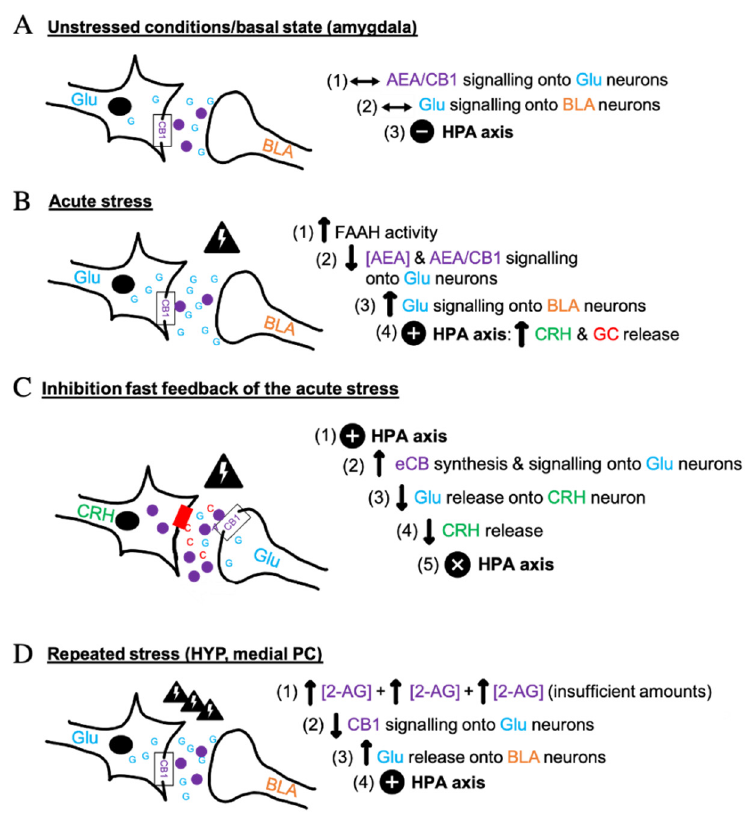
Figure 1. Interaction between endocannabinoids, glutamate, and the HPA axis under stressful conditions. This figure summarizes the theory presented by Hill et al. (2010) about the intervention of eCBs, the glutamatergic (Glu) system, glucocorticoids (GC) and the corticotropin-releasing hormone (CRH) in response to different stressful stimuli, the stress response being dependent on glutamatergic neurons and CB1 signaling in murine models. The synapses illustrated occur in the amygdala, hypothalamus (HYP), hippocampus or prefrontal cortex (PC). Symbols show the nature of the effect on the HPA axis, either neutral ( − ), excitatory ( + ) or inhibitory ( x ). ( A ) The non-stressed condition enables to maintain normal levels of AEA and to stabilize Glu activity onto the basolateral amygdala (BLA) neurons, which does not affect the HPA axis. Under acute stressful situations ( B ), the HPA is activated to ensure the survival of the organism. In response to stress, fatty acid amide hydrolase (FAAH) activation promotes the hydrolysis of AEA in all brain regions considered, whereas there are unchanged or lower 2-AG levels in the amygdala and in the HYP, respectively. The impaired AEA/CB1 signaling onto Glu synapses in turn induces a higher Glu input onto BLA neurons. A negative fast feedback occurs when there is a hypersecretion of cortisol ( C ). Biosynthesis of eCBs is then engaged to activate CB1 receptors in Glu terminals, thus diminishing or even suppressing Glu release and further CRH production in a retrograde manner. BLA-GABAergic outflow through eCB signaling can also generate a negative fast feedback in the amygdala. During chronic stress ( D ), the